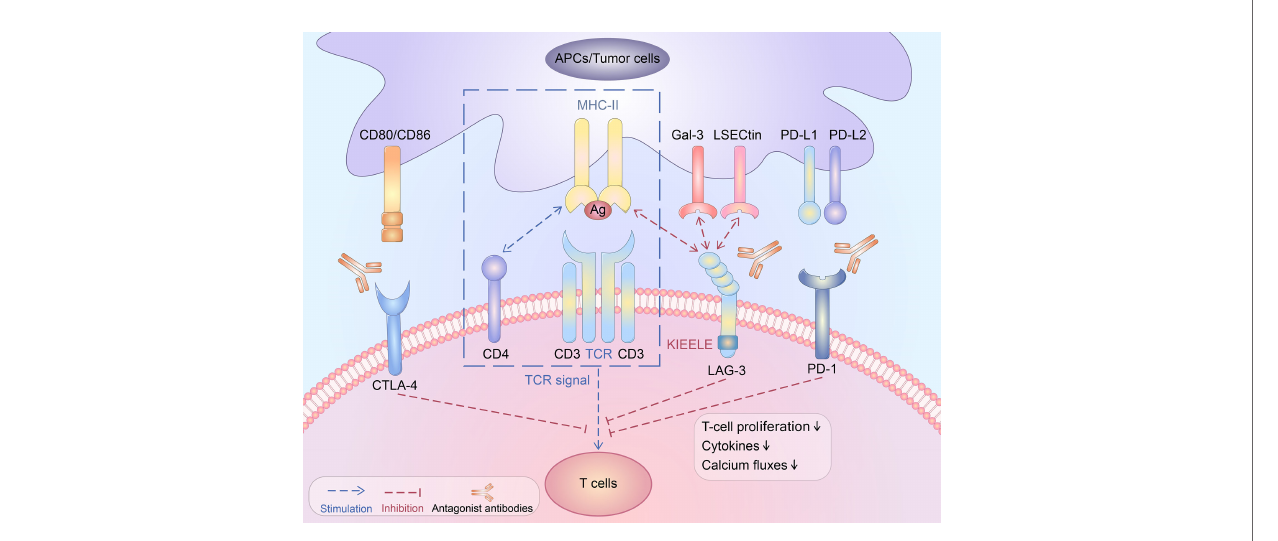
FIGURE 1 | The immunosuppressive function of